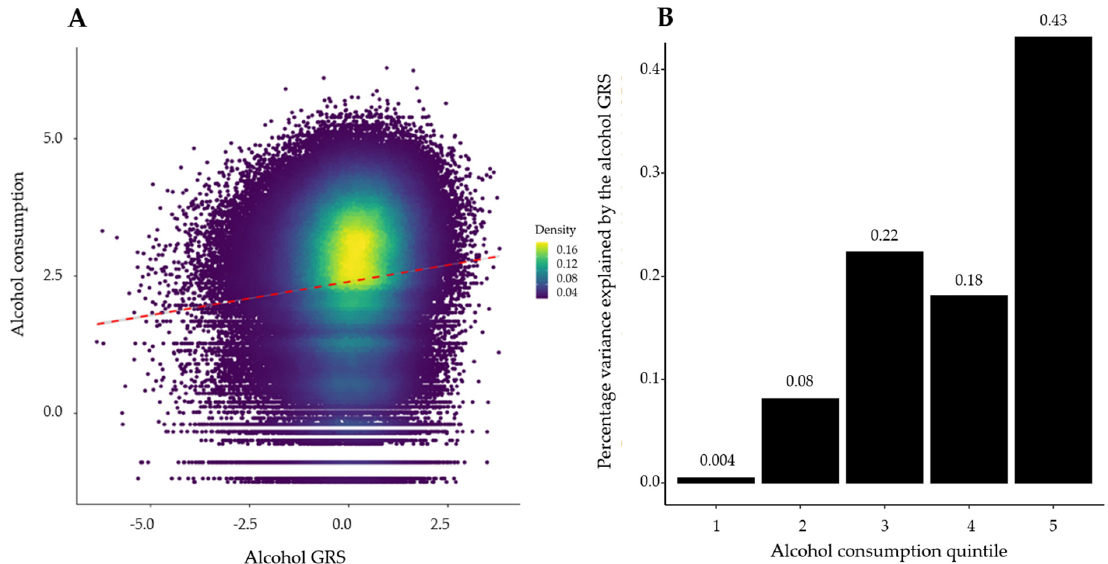
Figure 3. Relationship between the alcohol genetic risk score (GRS) and daily alcohol consumption. ( A ) Scatterplot illustrates the relationship between alcohol consumption (on a natural logarithm scale) and alcohol GRS. The red dotted line shows the gradient of the fitted regression line. ( B ) Per- centage variation in alcohol consumption explained by the alcohol GRS (adjusted R 2 estimate) within alcohol consumption quintiles. Quintile 1: 0 to 3.65 g/day; Quintile 2: 3.6–10.7 g/day; Quintile